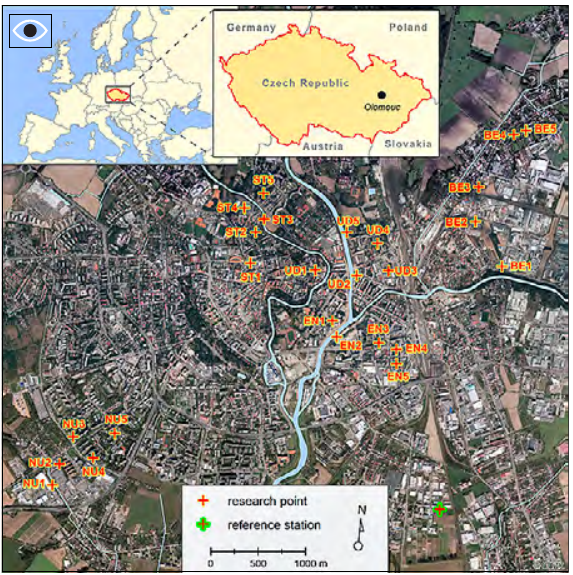
Figure 1. Study area and soil temperature measurement sites in Olomouc